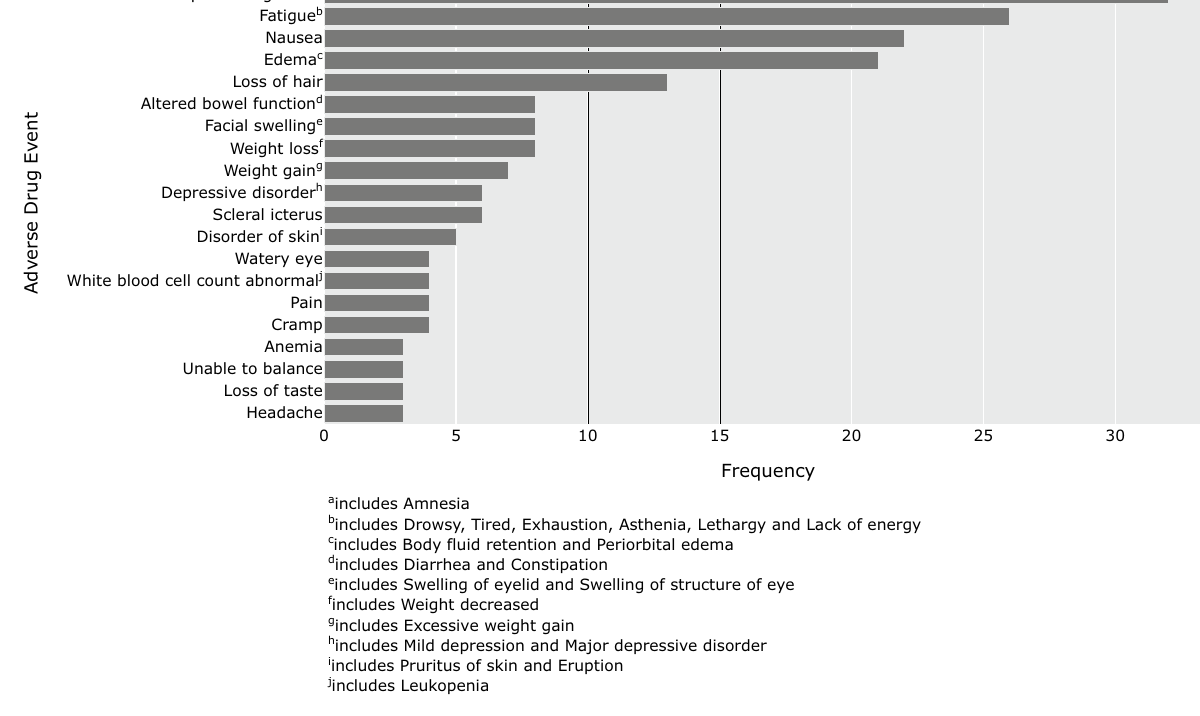
Figure 2. The 20 most prevalent adverse drug events reported for avapritinib (formerly BLU-285) on the GIST patient forum.